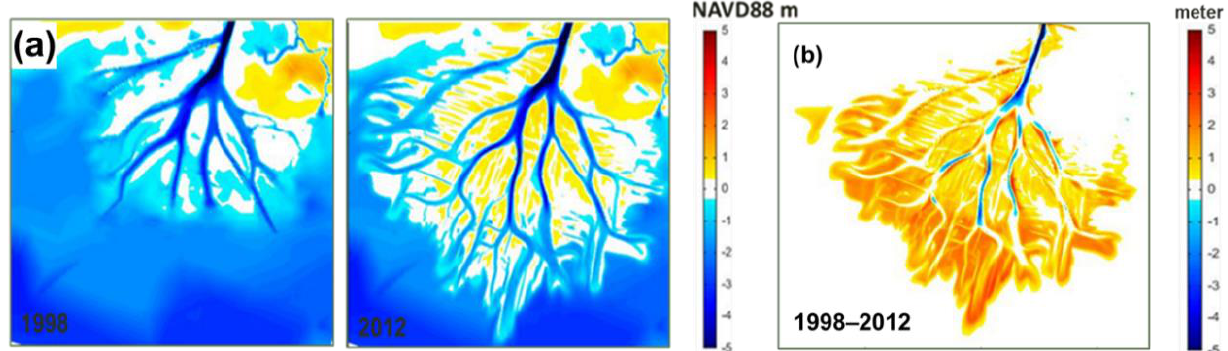
Figure 10. ( a ) Simulated topography of the Wax Lake Delta from 1998 to 2012. ( b ) Simulated cumulative erosion/deposition pattern in the Wax Lake Delta during 1998–2012.